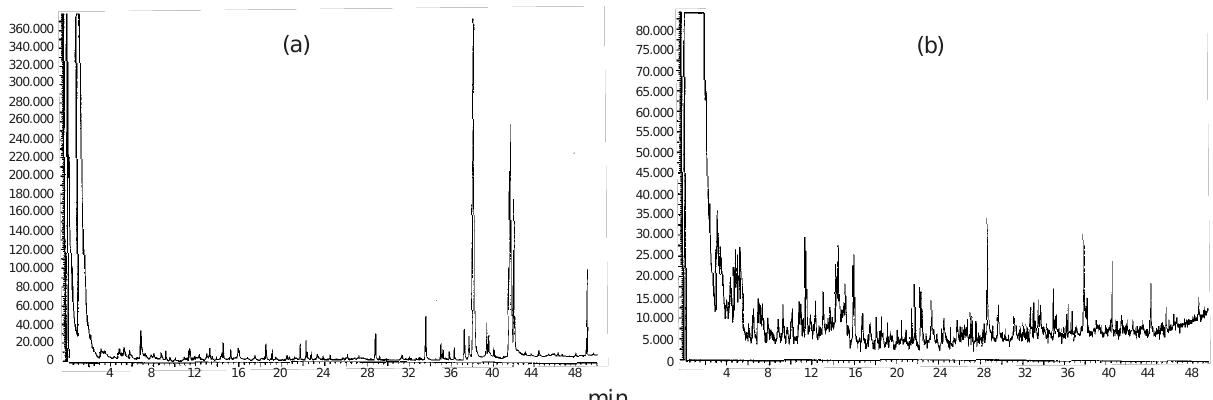
Figura 1. Cromatograma dos produtos da pirólise de ácidos húmicos extraídos do composto de resíduos sólidos (a) e de ácidos húmicos extraídos do lodo da estação de tratamento de esgotos (b).